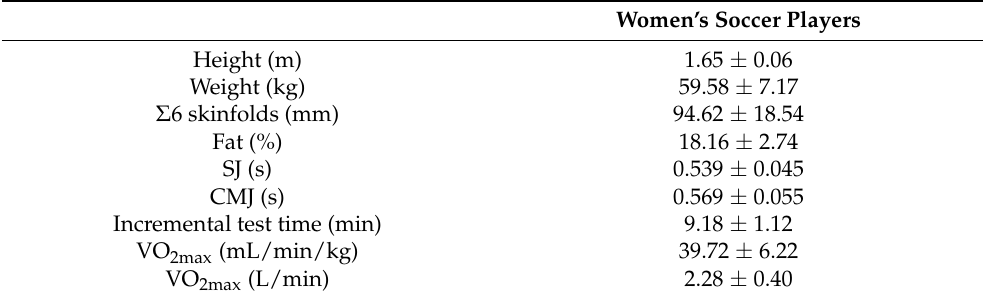
Table 3. Anthropometry, body composition and physical fitness